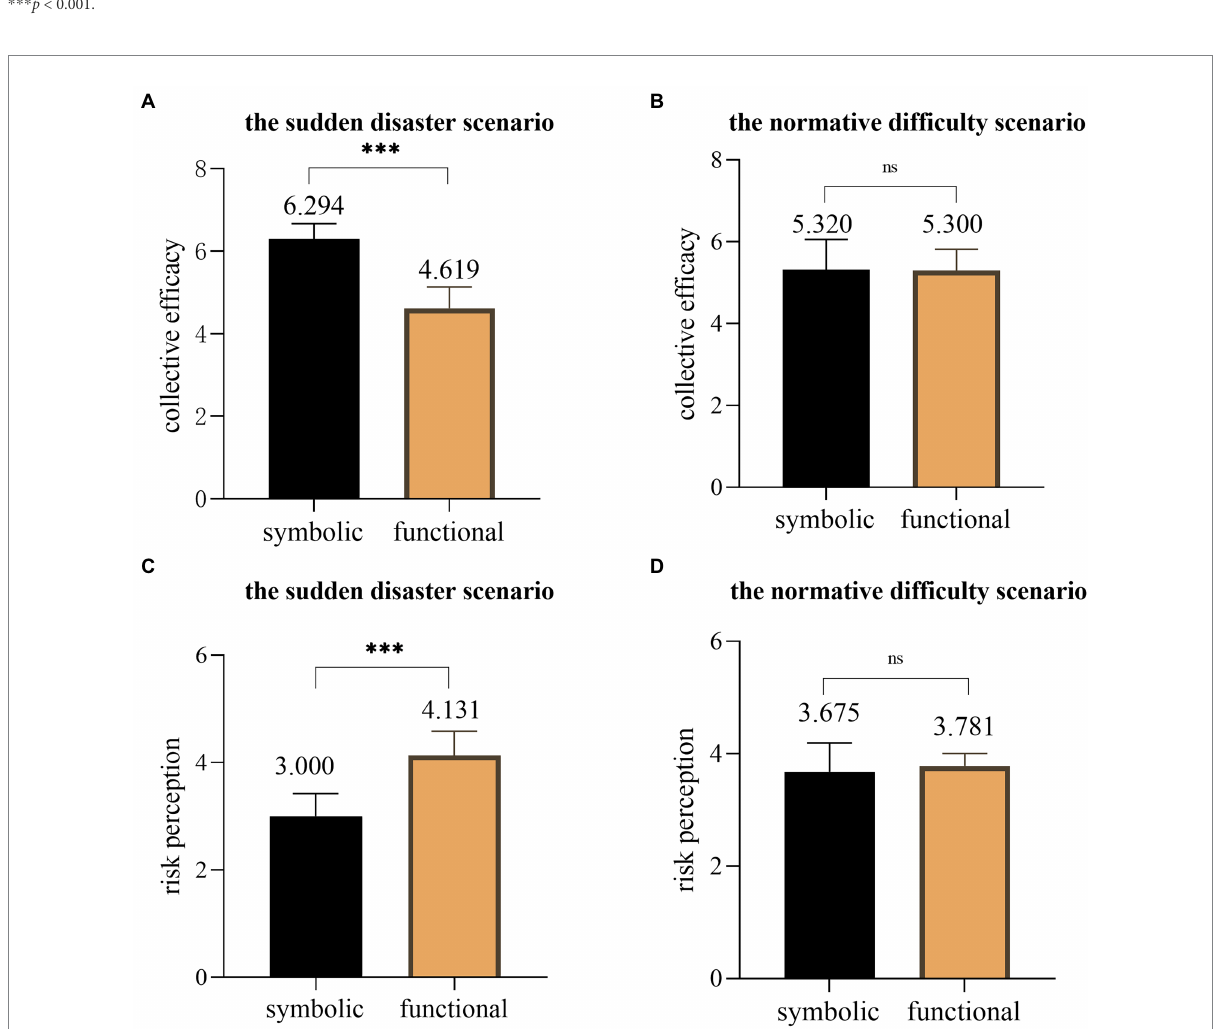
FIGURE 5 Multiple comparisons of symbolic ethical attributes with functional ethical attributes. (A) in the sudden disaster scenario, results of Study 3 on collective efficacy; (B) in the normative difficulty scenario, results of Study 3 on collective efficacy; (C) in the sudden disaster scenario, results of Study 3 on risk perception; (D) in the normative difficulty scenario, results of Study 3 on risk perception. *** p < 0.001; ns is not significant.